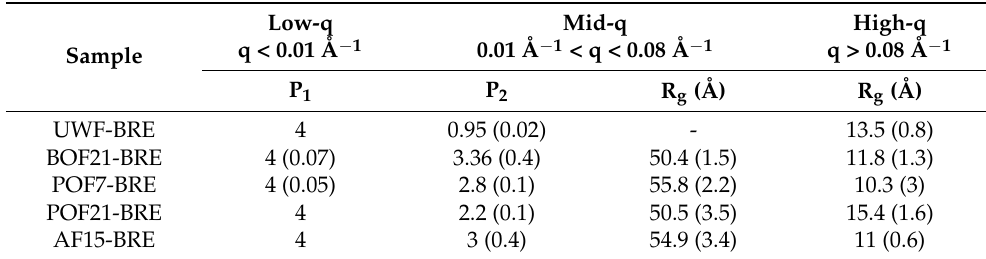
Figure 3. Effects of brown rot exposure on the SANS profiles from ( a ) unmodified wood fibers and fibers modified with ( b ) butylene oxide, ( c ) propylene oxide and ( d ) acetic anhydride. Open symbols and overlaid lines correspond to SANS data and model fits, respectively. Table 6. Effects of brown rot exposure on the scattering parameters. Uncertainties for each parameter are included in parenthesis.